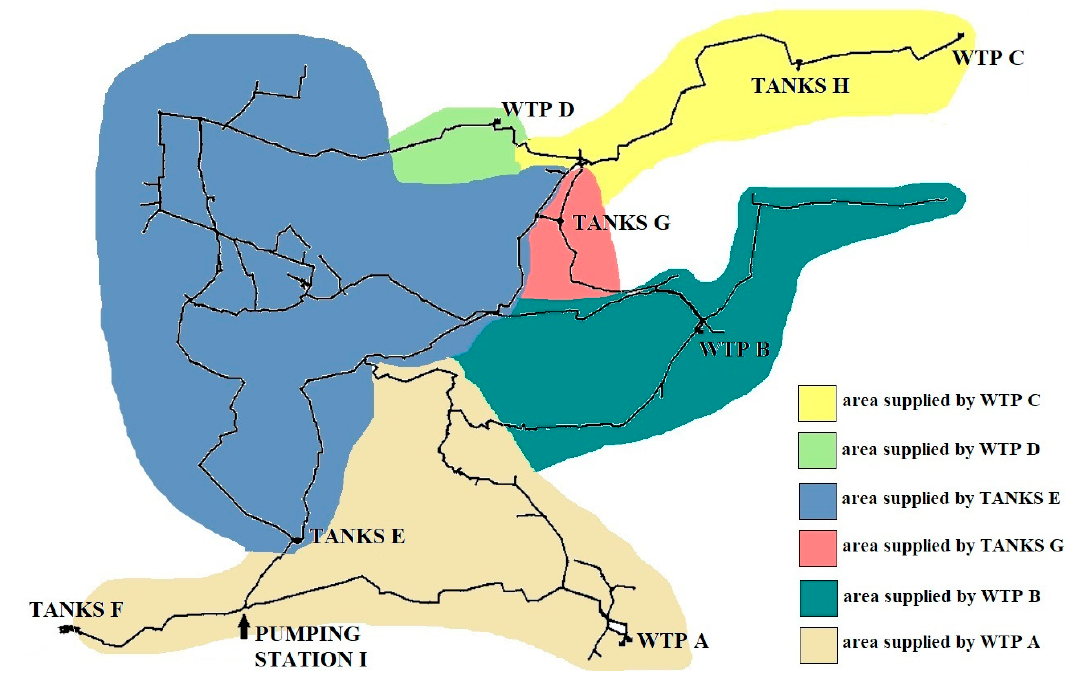
Figure 2. Structure of WDS with water supply areas.